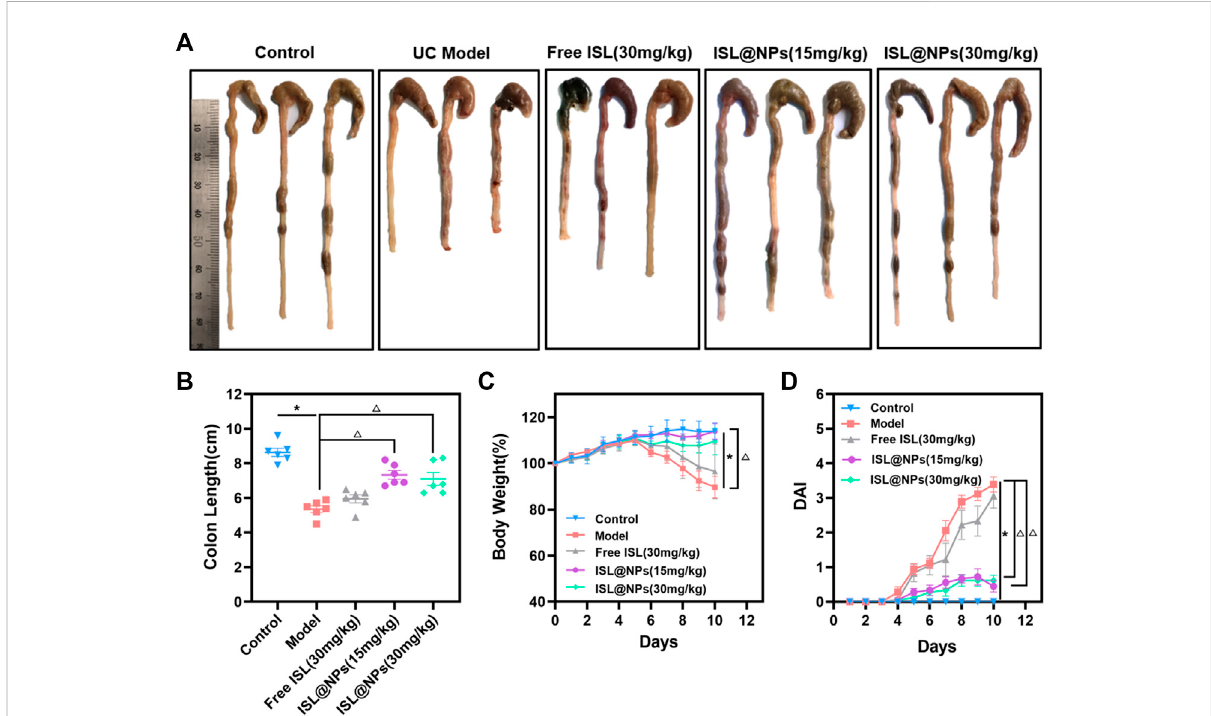
FIGURE 5 In vivo therapeutic ef fi cacy of ISL@NPs on DSS-inducedUCmice after 10days administration. (A) Representative colon photographs ofmice in different groups at day 10. (B) Quantitative analysis of colon length in different groups at day 10. The body weight curve (C) and the curves of DAI score (D) ofmiceindifferentgroupsduringthewholeexperimentalperiod.* p < 0.05(modelgroupvs.controlgroup), Δ p < 0.05(modelgroupvs.free ISL and ISL@NPs